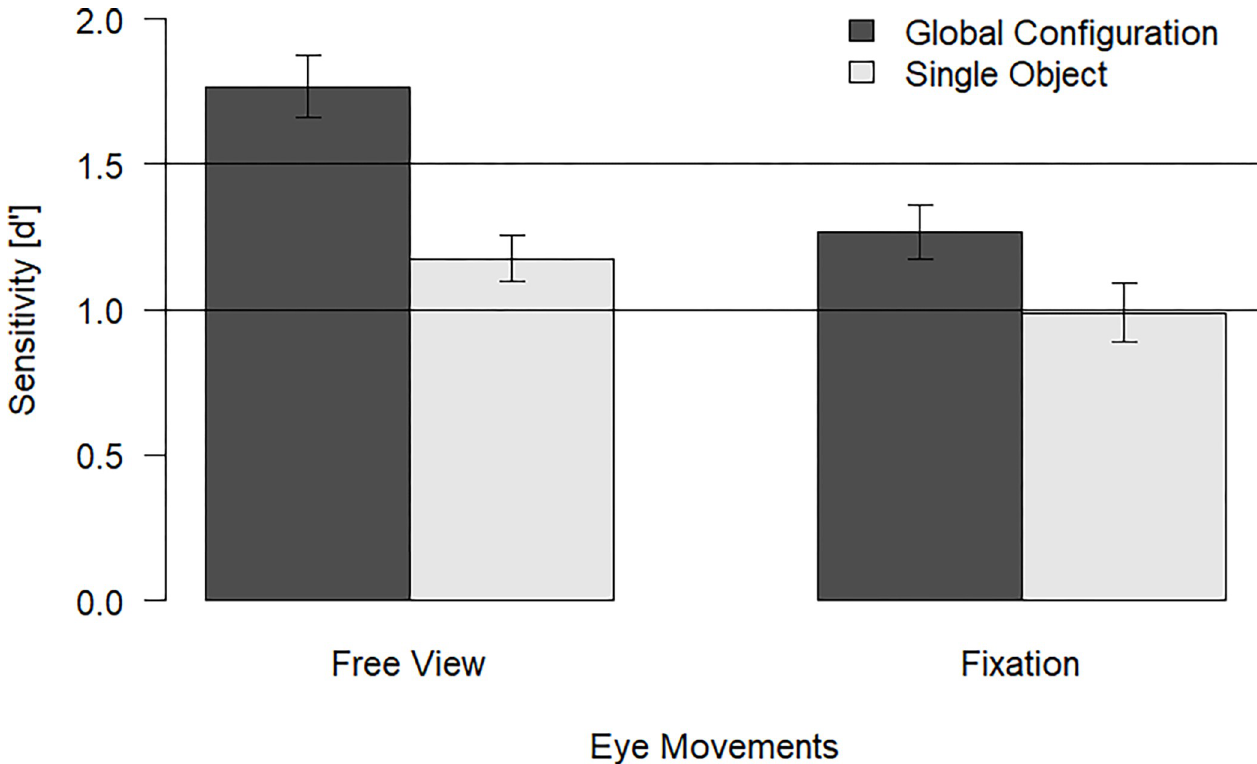
Fig 2. Sensitivity (d’) across conditions for Experiment 1. Error bars indicate the standard error of the mean (SEM).